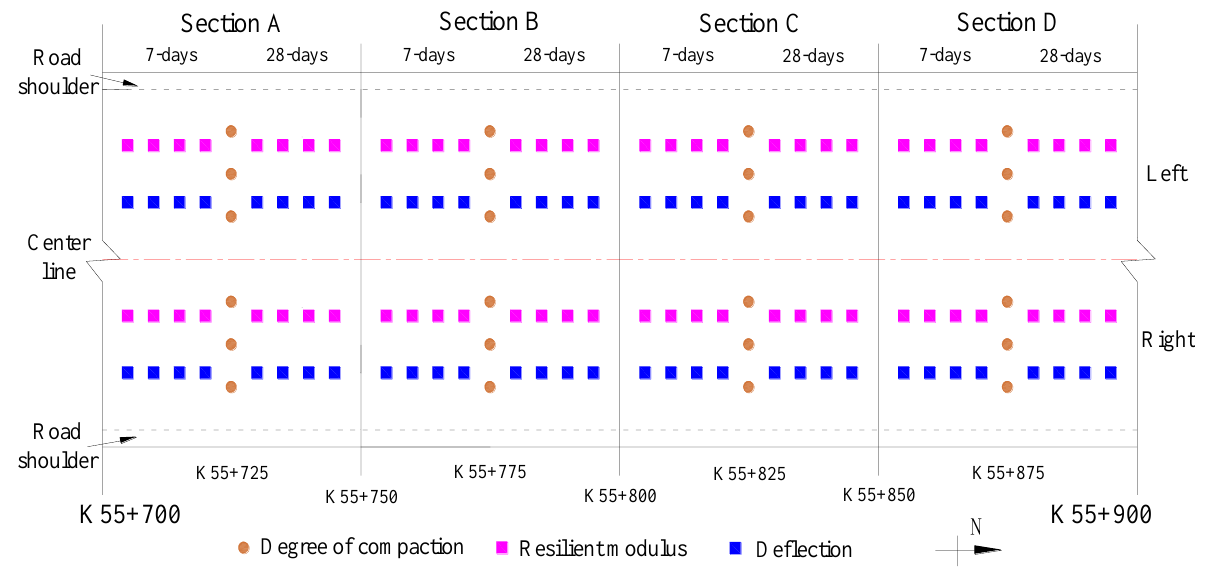
Figure 13. Schematic diagram of the location of in-situ tests. Table 5. Test cases of degree of compaction, resilient modulus and deflection.